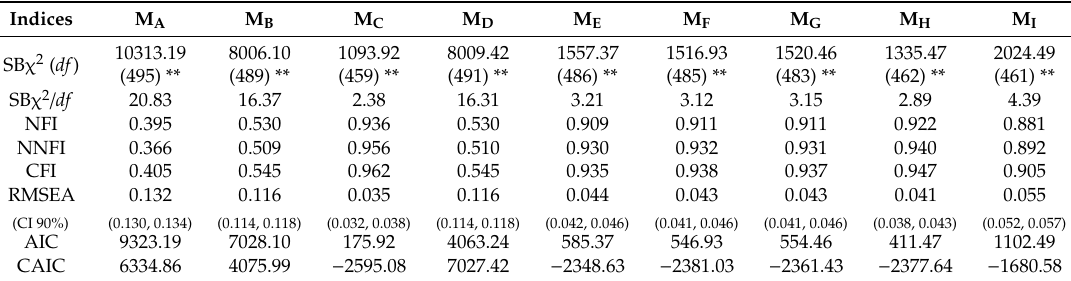
Table 2. Goodness-of-fit indices for the nine models